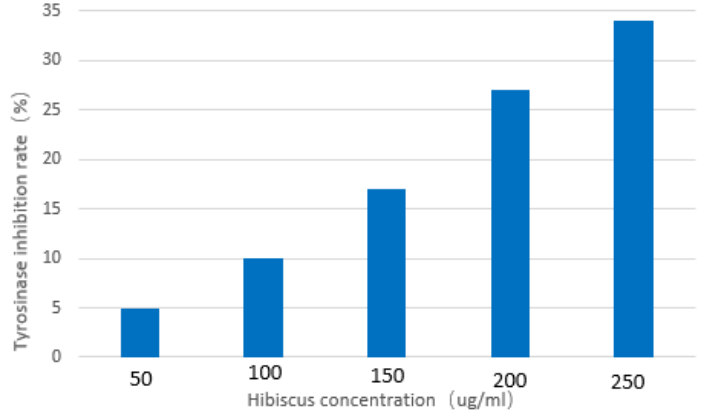
Figure 7. Effect of the extract concentration on the tyrosinase inhibitory activity.